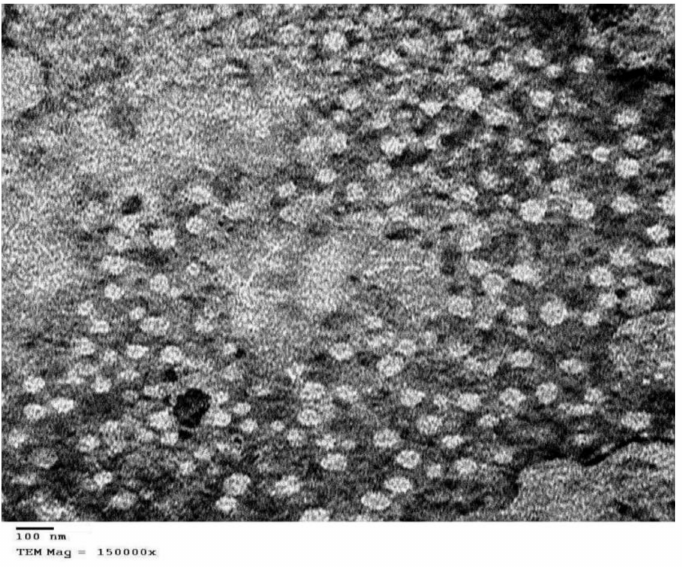
Figure 3. Transmission electron microscope images of